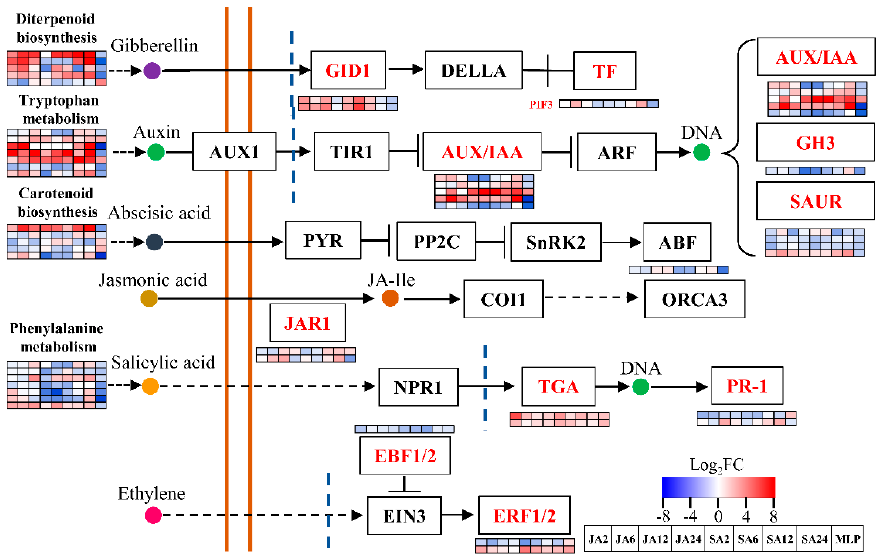
Figure 5. Common responsive genes assigned to plant hormone signal transduction and their upstream metabolism pathways. This figure was adapted from the KEGG pathway of plant hormone signal transduction. The gene expression levels of each treatment were shown in different columns as indicated in figure; the different rows represent the different genes. The colors indicate the gene expression levels.